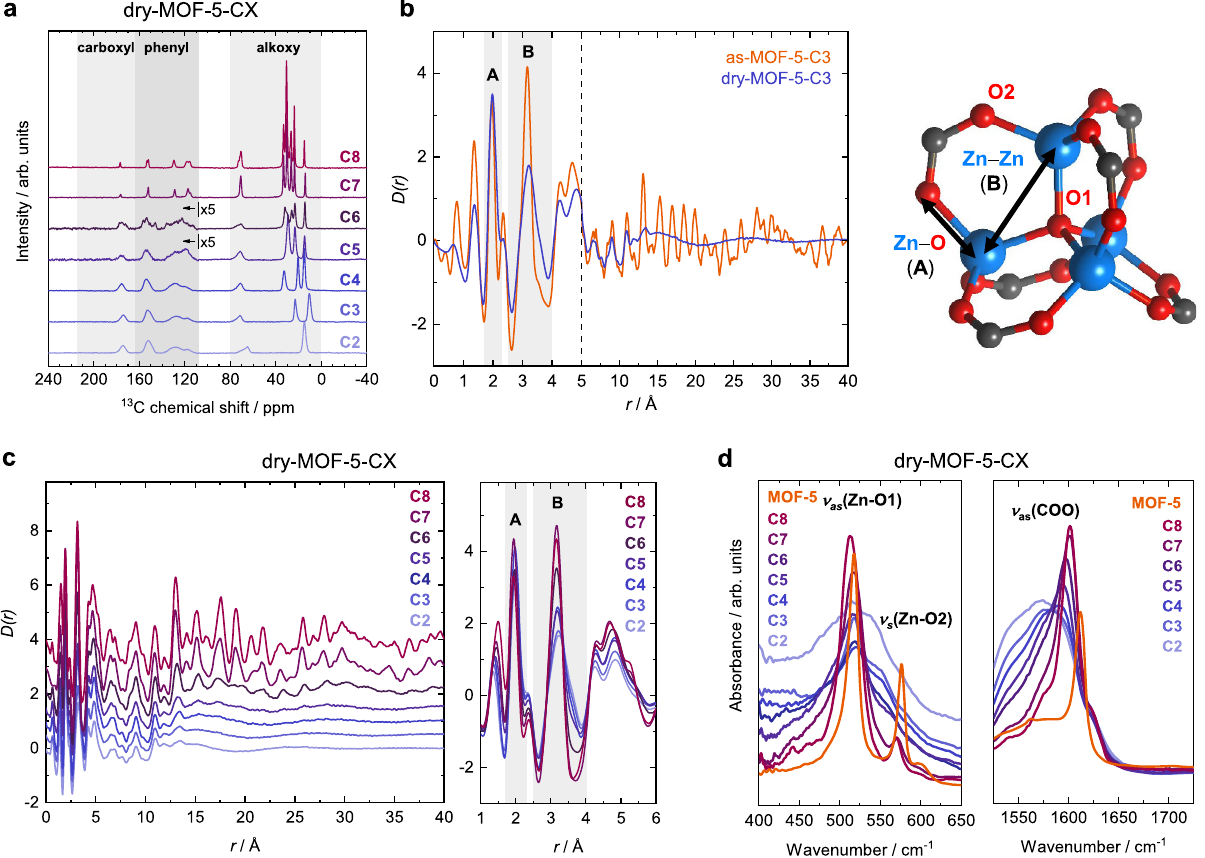
Fig. 3 Insights into the local structure by solid state NMR, XPDF and IR spectroscopy. a CP 13 C MAS NMR spectra of the dry-MOF-5-CX with highlighted spectral regions corresponding to carboxylate, phenyl or alkyl carbon atoms. b XPDFs of as- and dry-MOF-5-C3 and a representation of the [Zn 4 O(O 2 C) 6 ] node with distances important for the discussion marked. c Overlay of the XPDFs of dry-MOF-5-CX materials with emphasis on the change of the correlation length (left, XPDFs vertically offset) and the low- r region (right). d Excerpts from the IR spectral regions showing the ν as (Zn-O1) and ν ν s (Zn-O2) and the as (COO) vibrational bands of the dry-MOF-5-CX